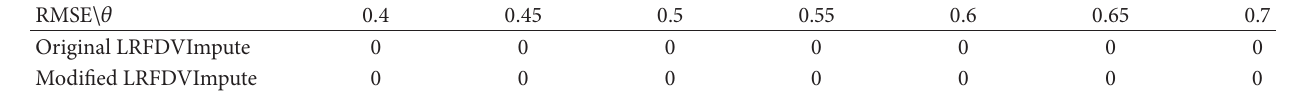
Table 4: Results for missing value estimation algorithm (Spellman, elu).